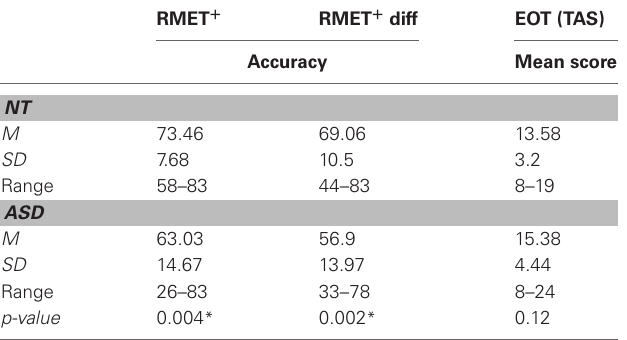
Table 2 | Group means, SD , range and group differences in accuracy and mean scores for the external socio-cognitive measures.